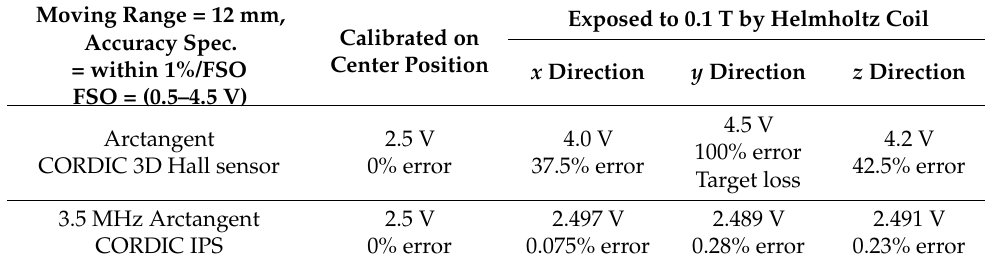
Table 1. Errors caused by exposure to strong magnetic field.